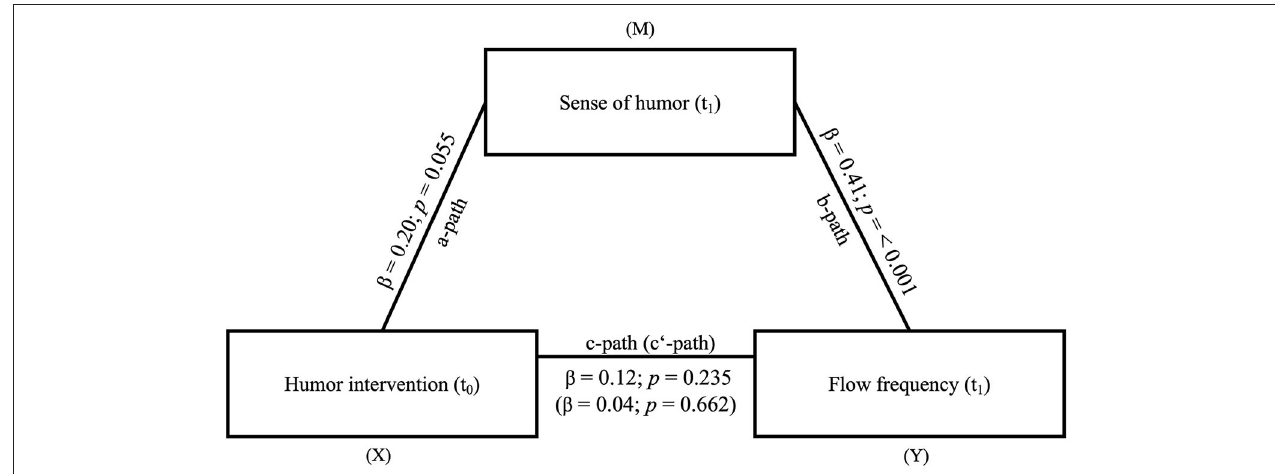
FIGURE 6 | Mediation model of the effect of the humor intervention (X) on flow frequency (Y) via sense of humor (M). N = 93. The indirect effect from (X = independent variable) to (Y = dependent variable) via (M = mediator) was significant ( β = 0.08, SE = 0.04, 0.01 < CI < 0.17); Measuring points: t 0 = Baseline; t 1 = 6 months after the humor intervention.